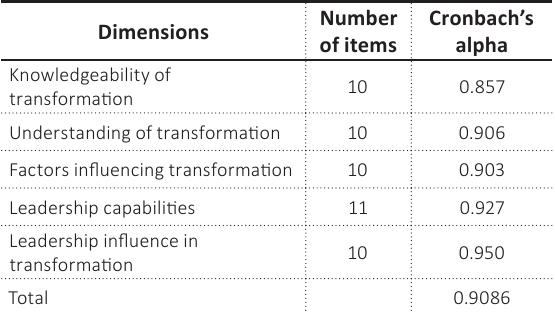
Table 1. Reliability analysis